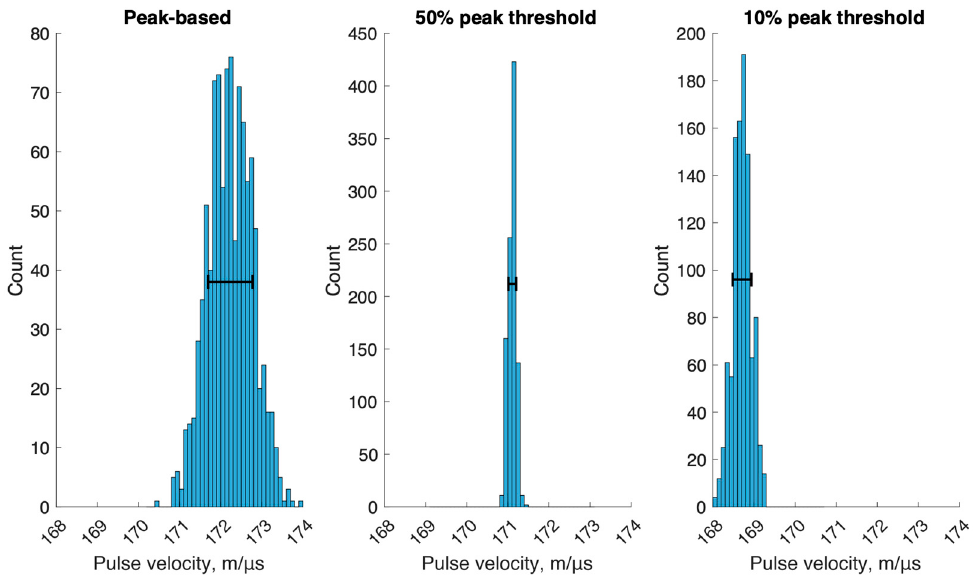
Figure 11. Pulse velocity histograms for 1 nC pulses (1000 total) injected at the far end of the cable, including SD around the mean, measured using the IEC 60270-compliant system. In the box-and-whisker plots, the box represents the interquartile range, i.e., the lower and upper edges correspond to the 25th and 75th percentile, respectively. The “whisker” lengths are chosen as 1.5 times the interquartile range, with any outliers separately plotted using a red circle as the marker. The median, i.e., the 50th percentile of the distribution, is denoted by the line in the middle part of the “box”. In the velocity histograms, the bin width is chosen as 0.1 m/ µ s across all the figures for easier comparison between the different measurement configurations. The histograms are supplemented with line sections, indicating one standard deviation (SD) on either side of the calculated mean velocity. The velocity measurement results are summarized in Table 1. Table 1. Summary of pulse propagation velocity measurement results based on di ff erent pulse char- acteristics, including deviation between mean value compared to peak-based measurement.